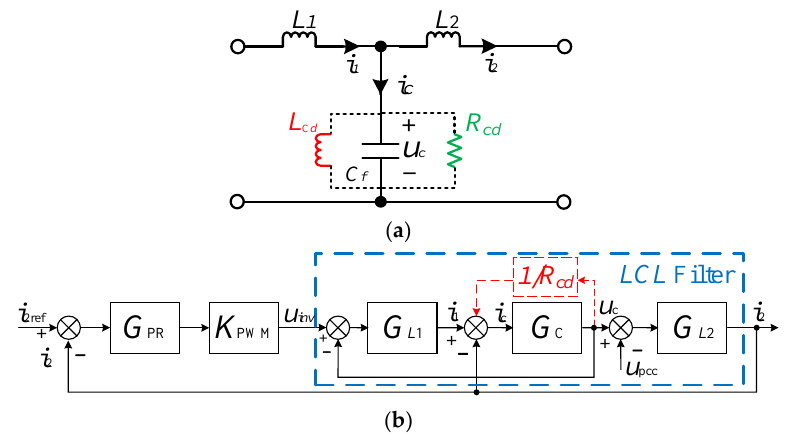
Figure 8. The LCL filter equivalent circuit and control block diagram: ( a ) The LCL filter equivalent circuit; ( b ) The control block diagram.